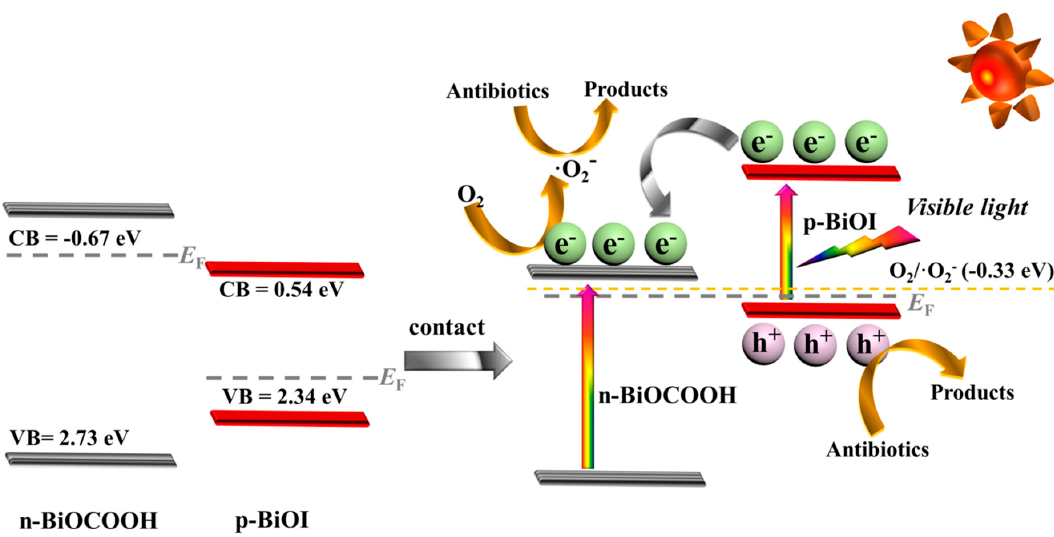
Figure 12. Proposed photocatalytic mechanism of the BiOI / BiOCOOH p–n heterojunction for the elimination of antibiotics under visible light.